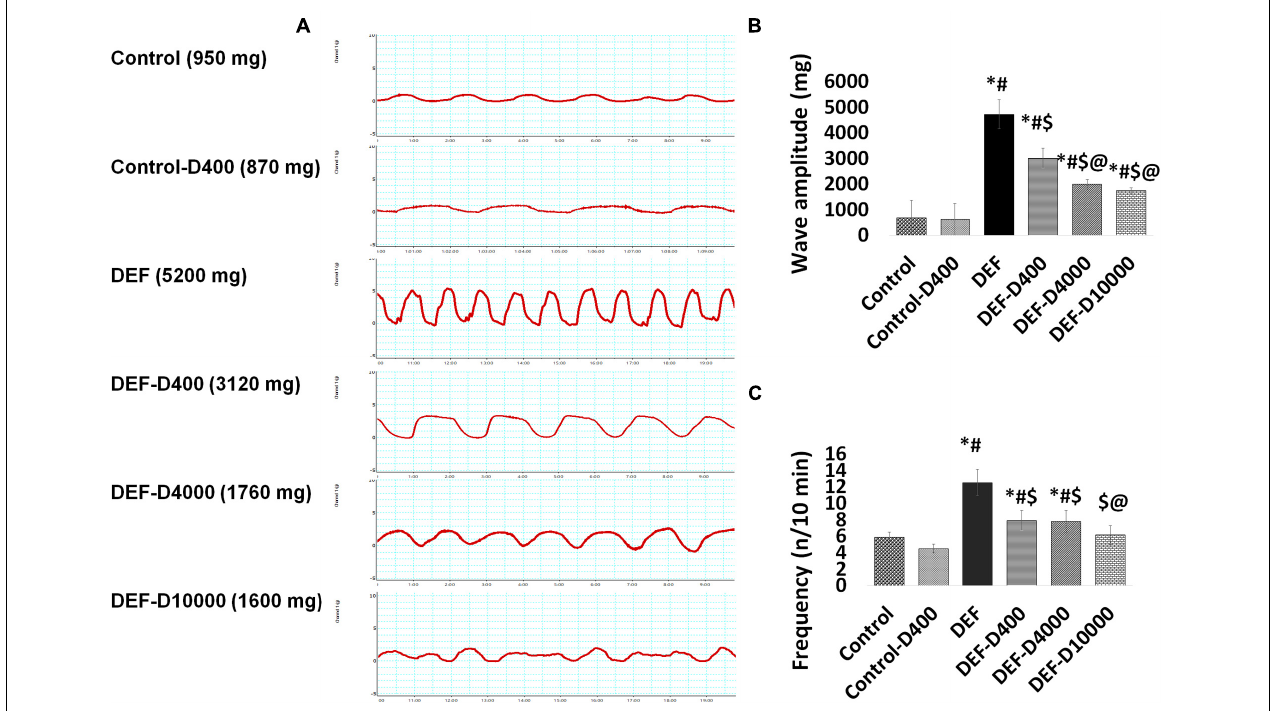
FIGURE 5 | The figure represents (A) the curves of the uterine contraction traced during 10 min after equilibration for 60 min, the scale of the Y axis is 15 g and the axis is 10 min. (B) The amplitude (mg) and (C) frequency (n/10 min) of the wave were calculated. D: refers to vitamin D supplementation in different doses equivalent to 400, 4,000, and 10,000 IU. DEF: means vitamin D deficiency. ∗ : Statistically significant sign compared to the control group, # : compared to control-400, $: compared to the deficiency group, and @: compared to DEF-400 ( P <